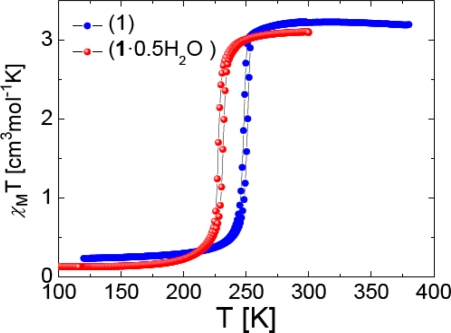
Thermal variation of χMT of 1·0.5H2O (depicted in red) and 1 (depicted in blue).